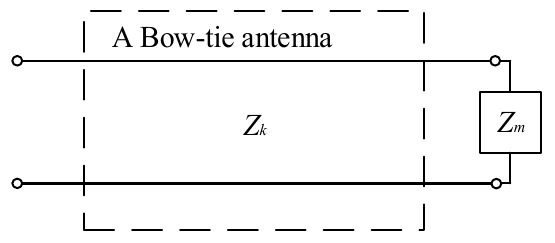
Figure 2. The transmission line model of the Bow-tie antenna.